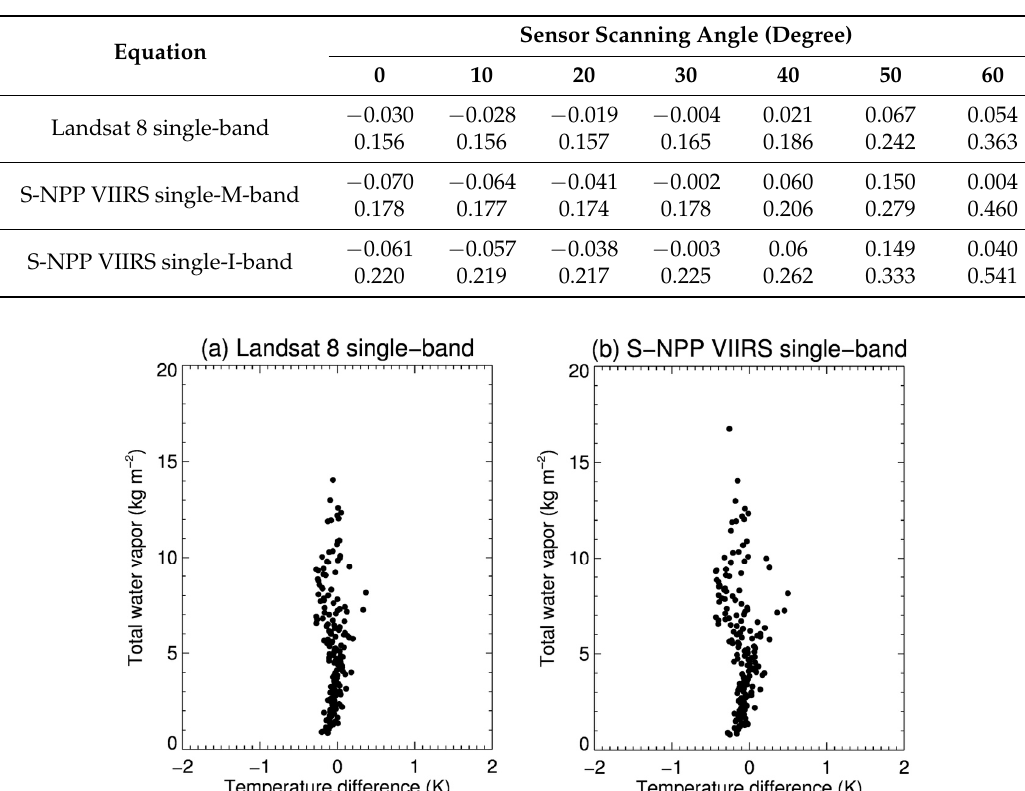
Table 4. Bias (top row in a cell) and standard deviation (bottom row in a cell) of differences between single-band retrievals using Equation (3) and true surface temperatures for Landsat 8 and S-NPP VIIRS in the Arctic.